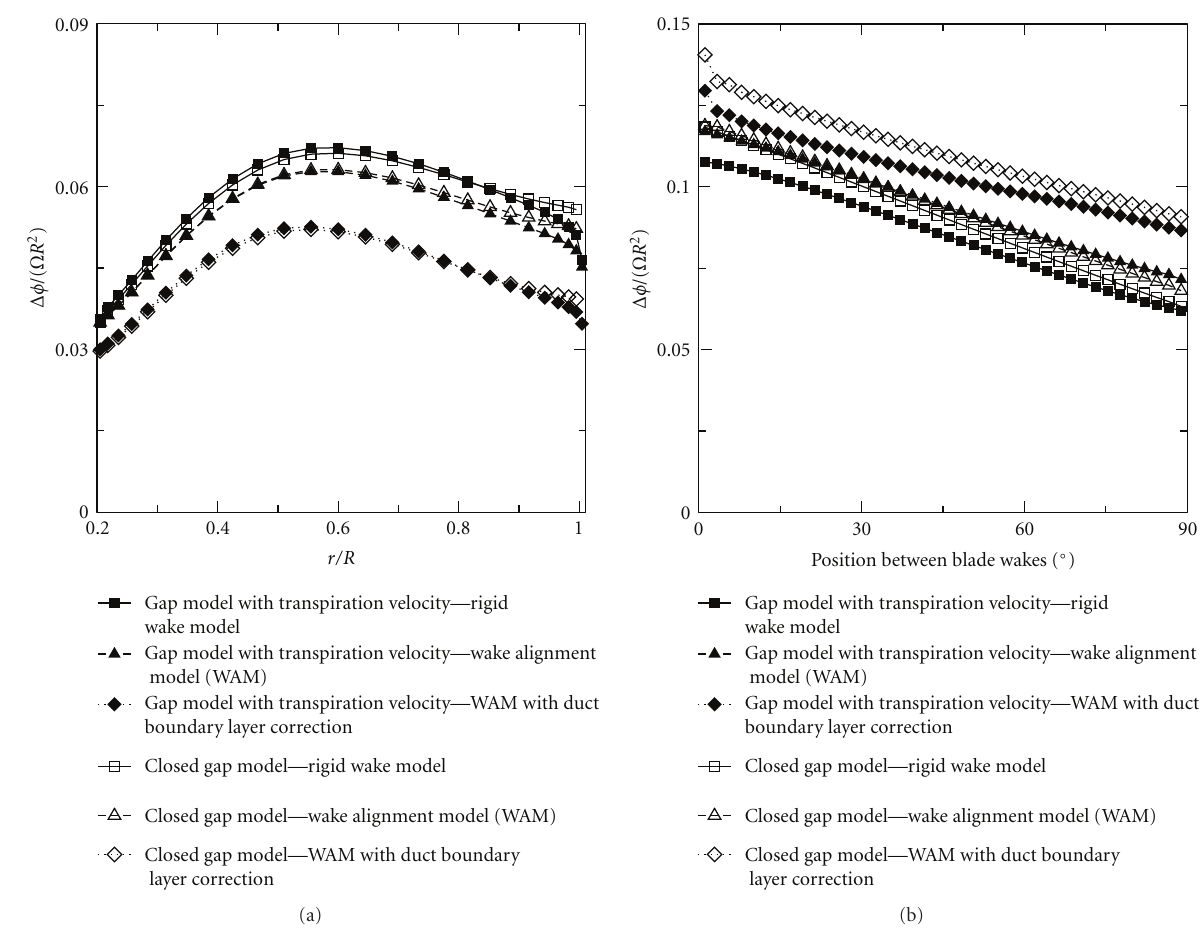
Figure 11: Blade (a) and duct (b) circulation distributions. Influence of gap and wake models. Ka4-70 inside duct 19Am at J = 0 .